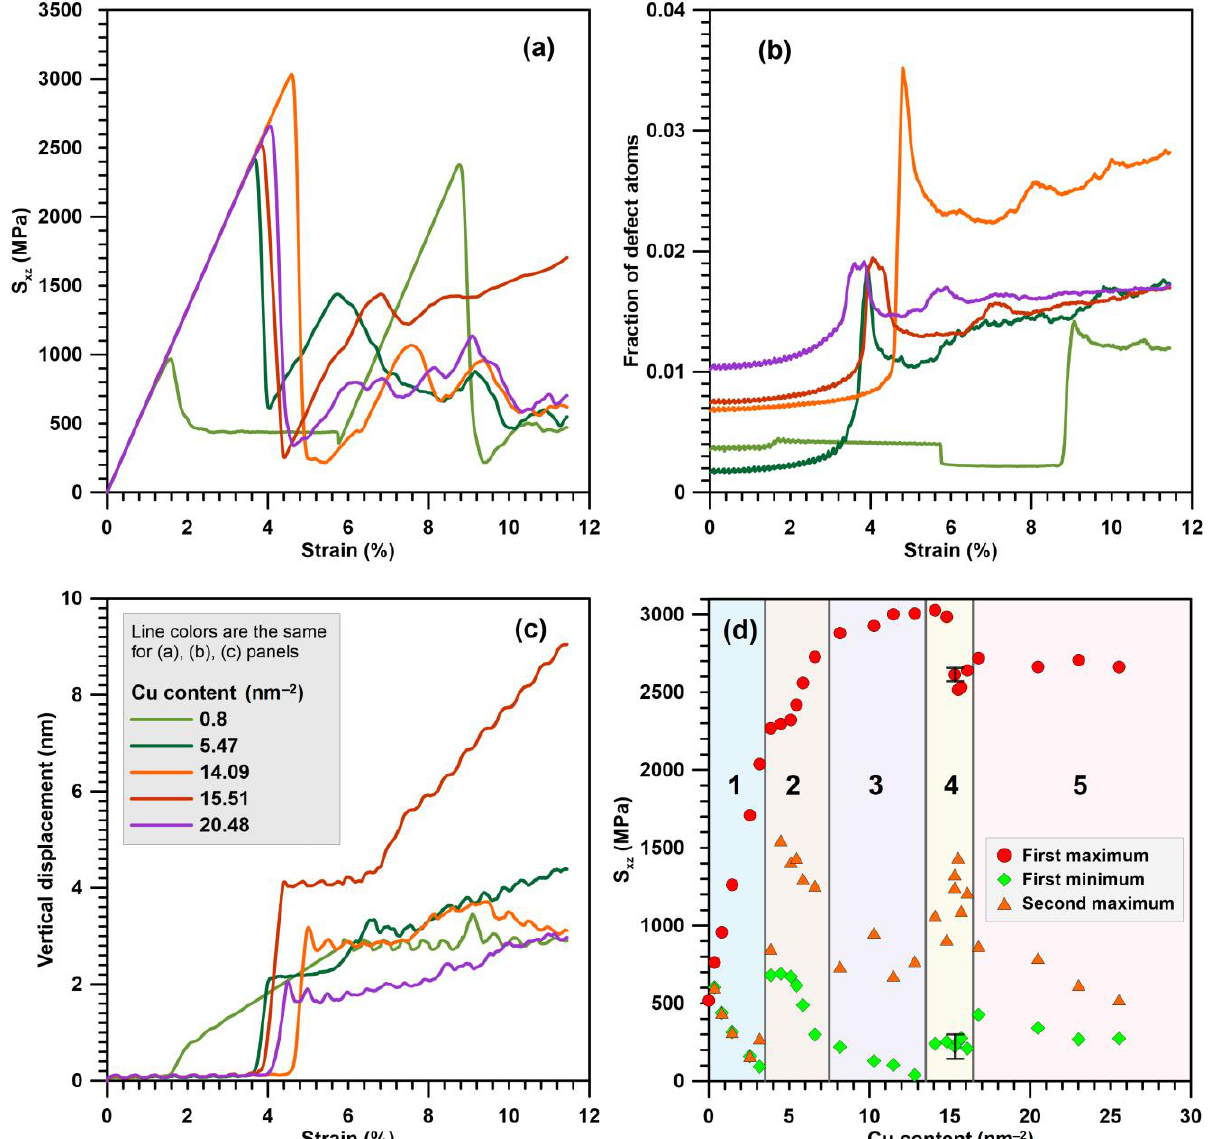
Figure 5. ( a ) Stress – strain dependencies, ( b ) dependencies of the defect atom fraction on the strain and ( c ) dependencies of maximal atom displacement. ( d ) Dependencies of the critical resolved shear stress of the first minimum and the second maximum at stress – strain curves on Cu content at GBs. Area “ 1 ” corresponds to plastic relaxation due to GB slip as dislocation walls. In area “ 2 ” , plastic relaxation occurs due to grain rotation. In areas “ 3 ” and “ 5 ” , plastic relaxation occurs due to GB and intragranular dislocation processes. In area “ 4 ” , GB dislocation emission stimulates sliding of grains along one GB with rotation of the system as a whole. The error bars mark the standard deviation in the results of 5 calculations for a system with 100% filling of three Cu columns (Cu content is 15.32 nm −2 ).